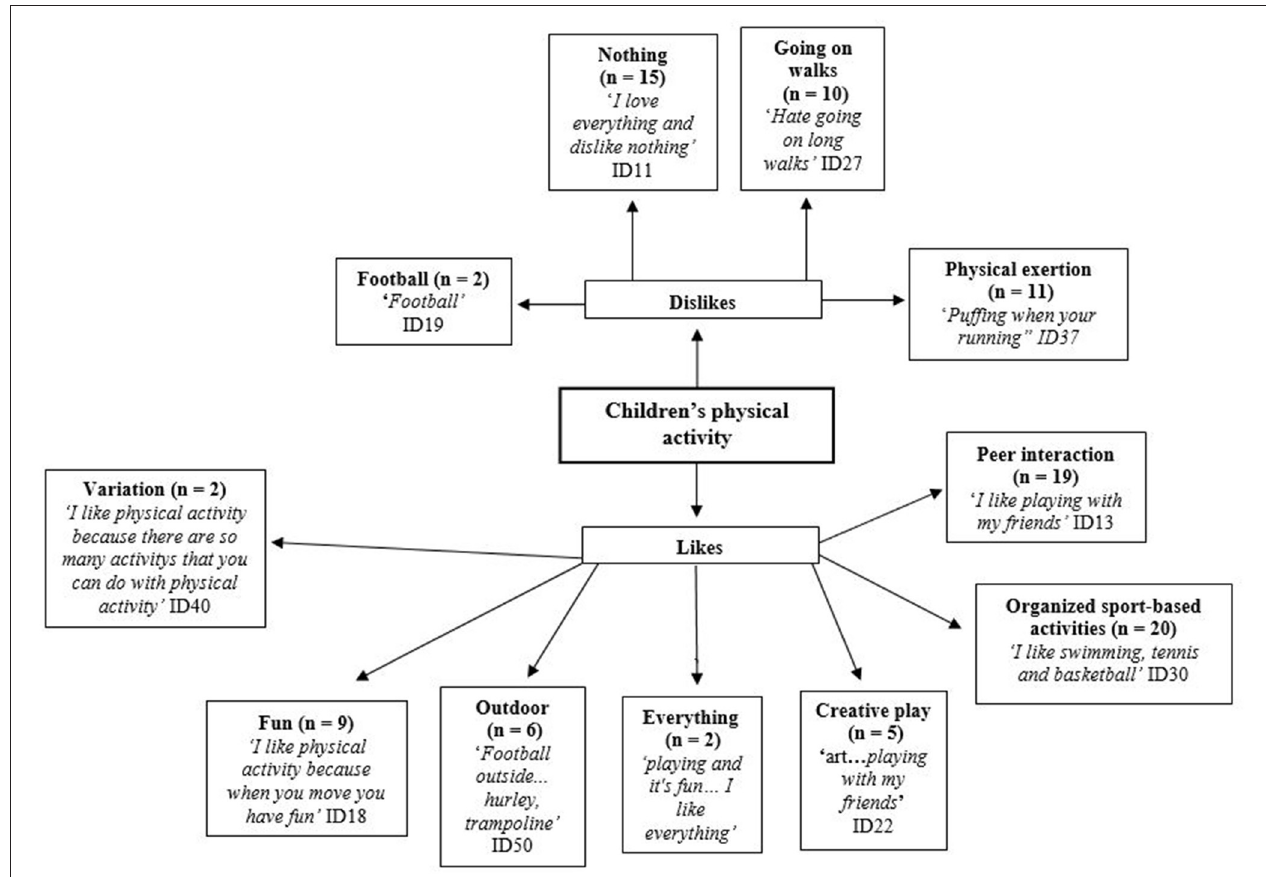
FIGURE 2 | Children’s likes and dislikes toward physical